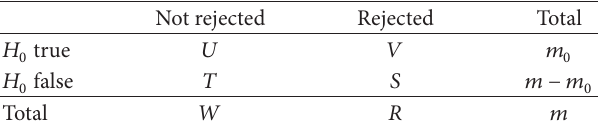
Table 1: Outcomes from m null hypotheses